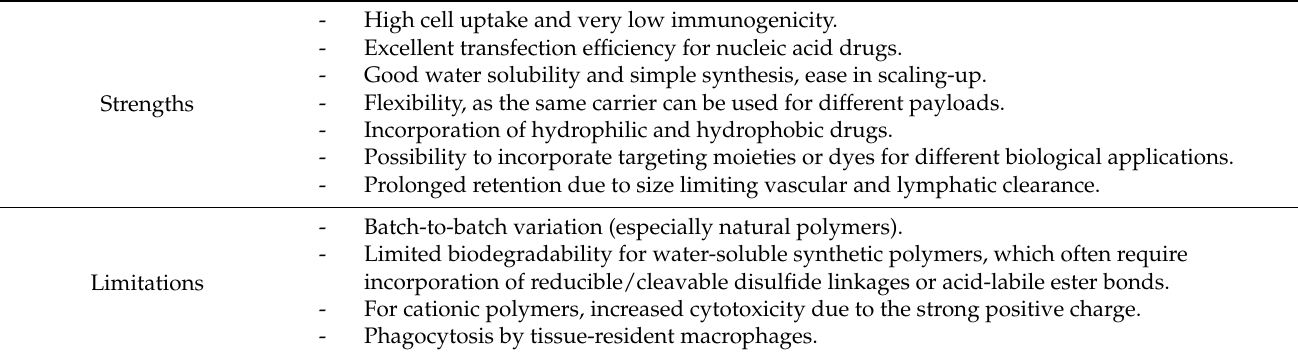
Table 1. Summary of possible strengths and limitations in the use of polymeric nanoparticles as drug delivery